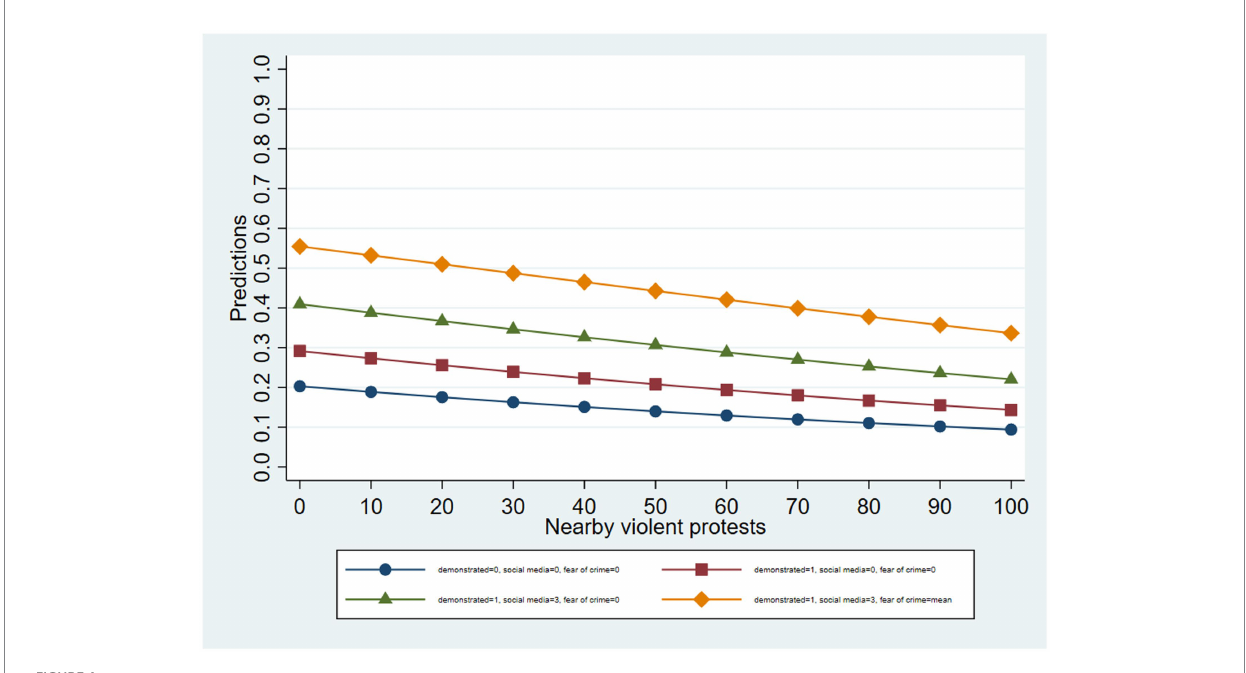
FIGURE 4 Adjusted predictions of stating that the police violated human rights “very